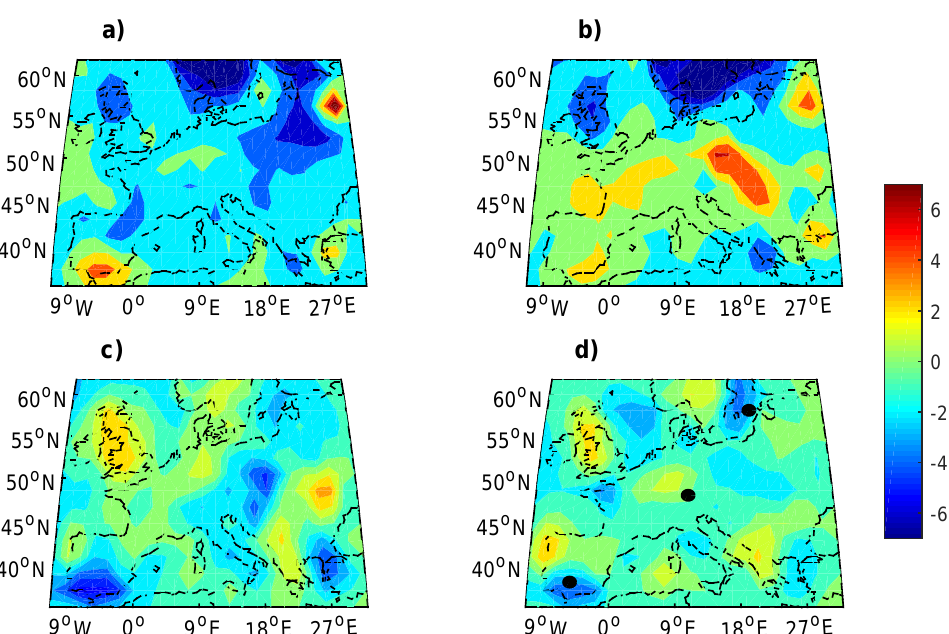
Figure 6. Average biases of models EMM for T min ( a , b ) and EMM T max ( c , d ) with respect to the 20CRv2c return levels. Different bin length m are represented: 1 year ( a , c ) and 4 years ( b , d ). Detailed statistical information about this figure in Table 3 (Ensemble). The three black dots in ( d ) correspond to central (Figure 2a), northern (Figure 2b), and southern (Figure 2c) points of Figure 2.